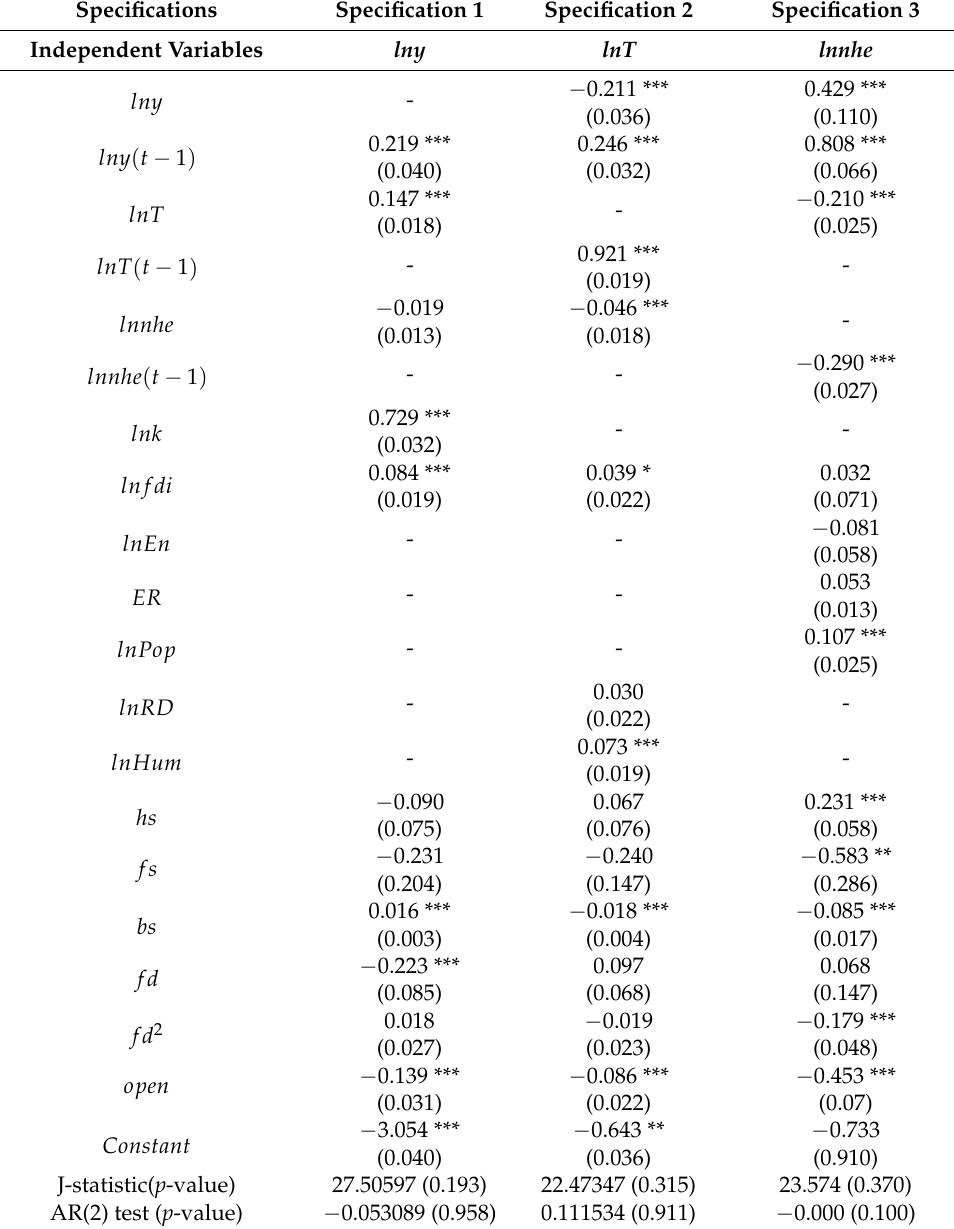
Table 6. Generalized method of moments (GMM) estimation results of panel simultaneous equations of Equations (11)–(13) ( R represents nhe